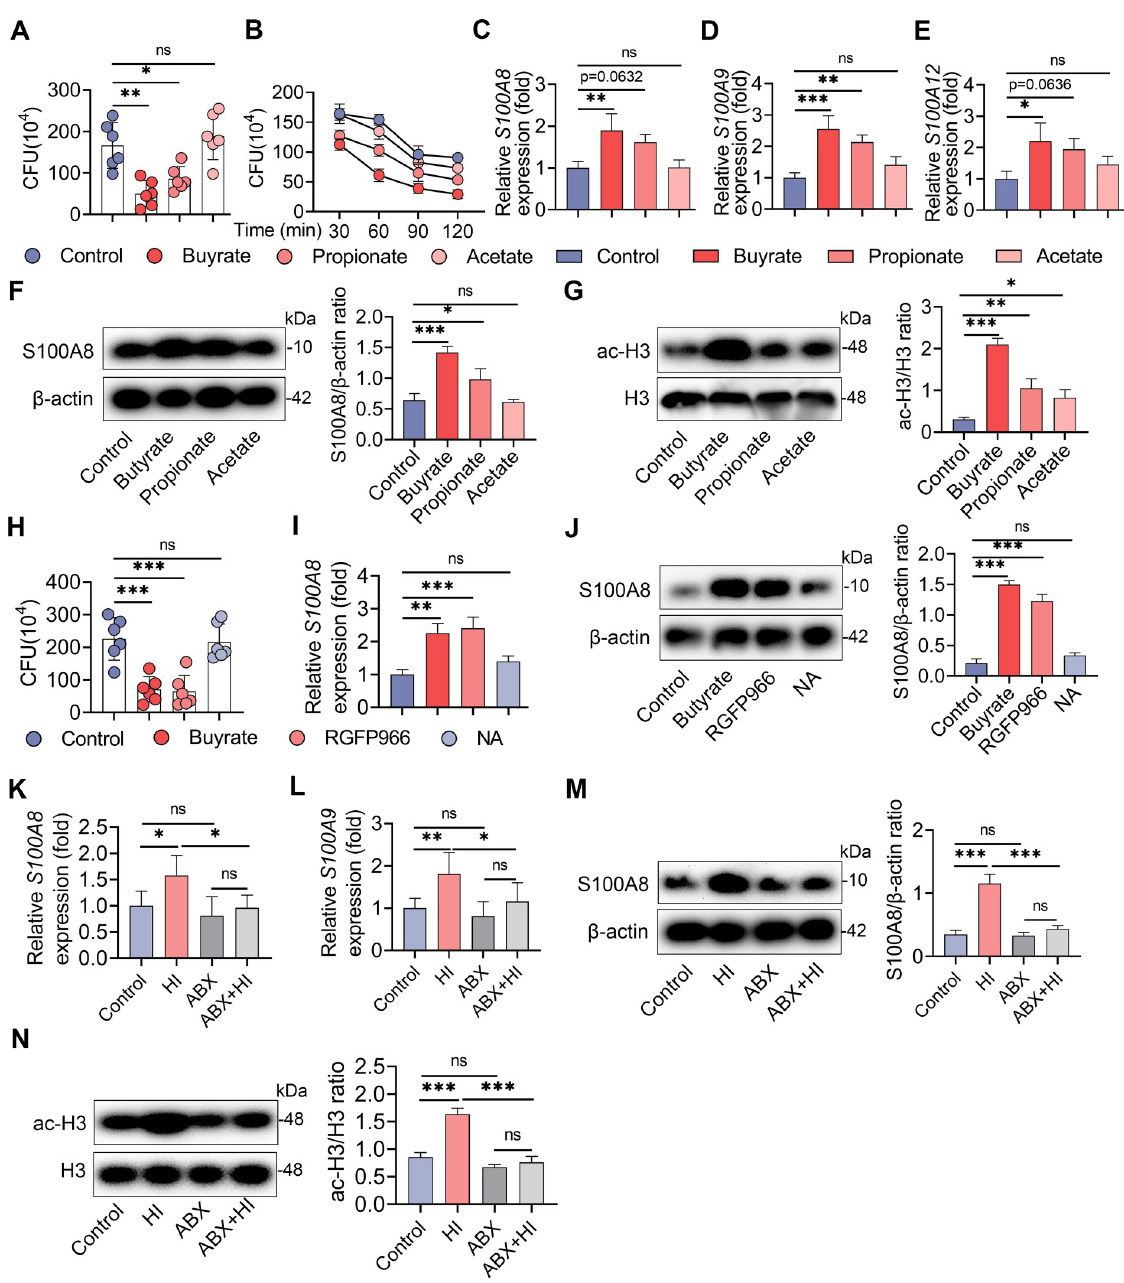
Fig 7. The HI diet activates macrophages antimicrobial defense through SCFA-mediated HDAC inhibition. Mice were treated with 30 mg/kg butyrate, propionate and acetate for a week, and then macrophages were isolated (A-G ). A . Macrophages were infected with S . au (MOI of 10) for 1 h and intracellular bacterial loads were detected by gentamicin protection assay (n = 6). B . Intracellular bacterial loads in macrophages at different times after infection. C-E . Relative gene expression of S100A8 , S100A9 and S100A12 in macrophages from different treatment groups by qPCR (n = 6). F . Relative expression of S100A8 antimicrobial protein in macrophages in different SCFA treatment groups. G . Expression of HDAC3 and acetylated H3 proteins in macrophages from the indicated groups. H-I . Mice were treated with butyrate, RGFP966 and NA for a week, and then macrophages were isolated (n = 6). H . Intracellular bacterial loads from indicated groups (n = 6). I . Relative gene expression of S100A8 in macrophages from the indicated groups. J . Relative expression of S100A8 protein in macrophages in different treatment groups. K-N . Macrophages were isolated from the control diet or HI diet treatment groups with or without depletion of the gut microbiota. K and L . Relative gene expression of S100A8 and S100A9 in macrophages from different treatment groups by qPCR. M . Expression of S100A8 protein in macrophages in different groups. N . Expression of HDAC3 and acetylated H3 proteins in macrophages from the indicated groups. Data are presented as the means ± SD ( A-N ) and one-way ANOVA was performed for statistical analysis. � p < 0.05, �� p < 0.01 and ��� p < 0.001 indicate significant differences.